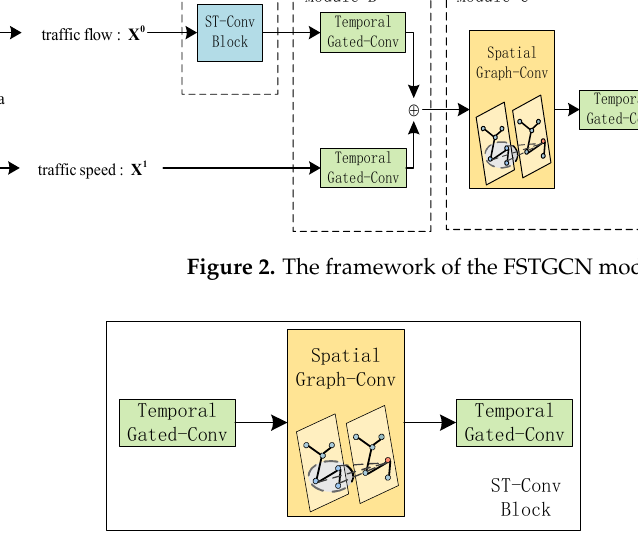
Figure 3. The framework of the ST-Conv block.